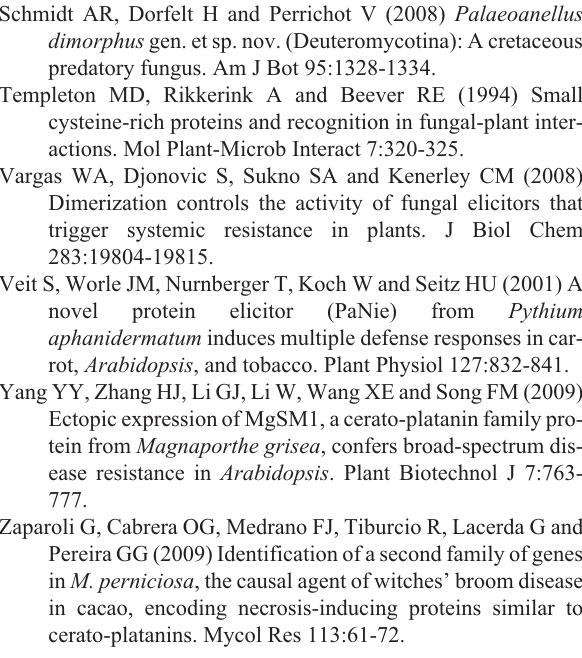
sification. Table S2 - Hydrophobicity of the putative amino acids from the sequences in group IV. Table S3 - The secondary structure and surface-interior prediction of the putative amino acids of the sequences in group IV. Table S4 - The divergence times of the cerato-platanin pro- tein genes, corresponding fungi and the fungal host. Table S5 - Cumulative substitutions in branches with posi- tive selection. Figure S1 - Phylogenetic relationships and divergence times of fungi with known genes in the cerato-platanin fam- ily. Figure S2 - Phylogenetic relationship and divergence times of genes in the cerato-platanin family of Ascomycetes. Figure S3 - Phylogenetic relationship and divergence times of genes in the cerato-platanin family of